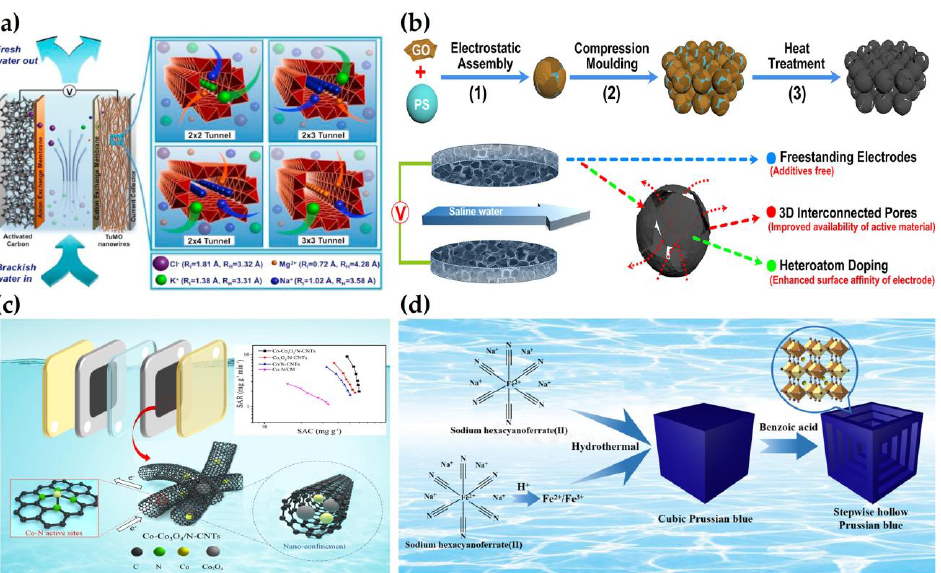
Figure 3. ( a ) Manganese oxide nanowires with different tunnel crystal structures as HCDI electrodes for ion removal [38]. Copyright 2018, Elsevier. ( b ) Schematic diagram of the construction process of graphene-based freestanding membrane electrodes and seawater desalination [44]. Copyright 2022, Elsevier. ( c ) Co-Co 3 O 4 encapsulated in nitrogen-doped carbon nanotubes for capacitive